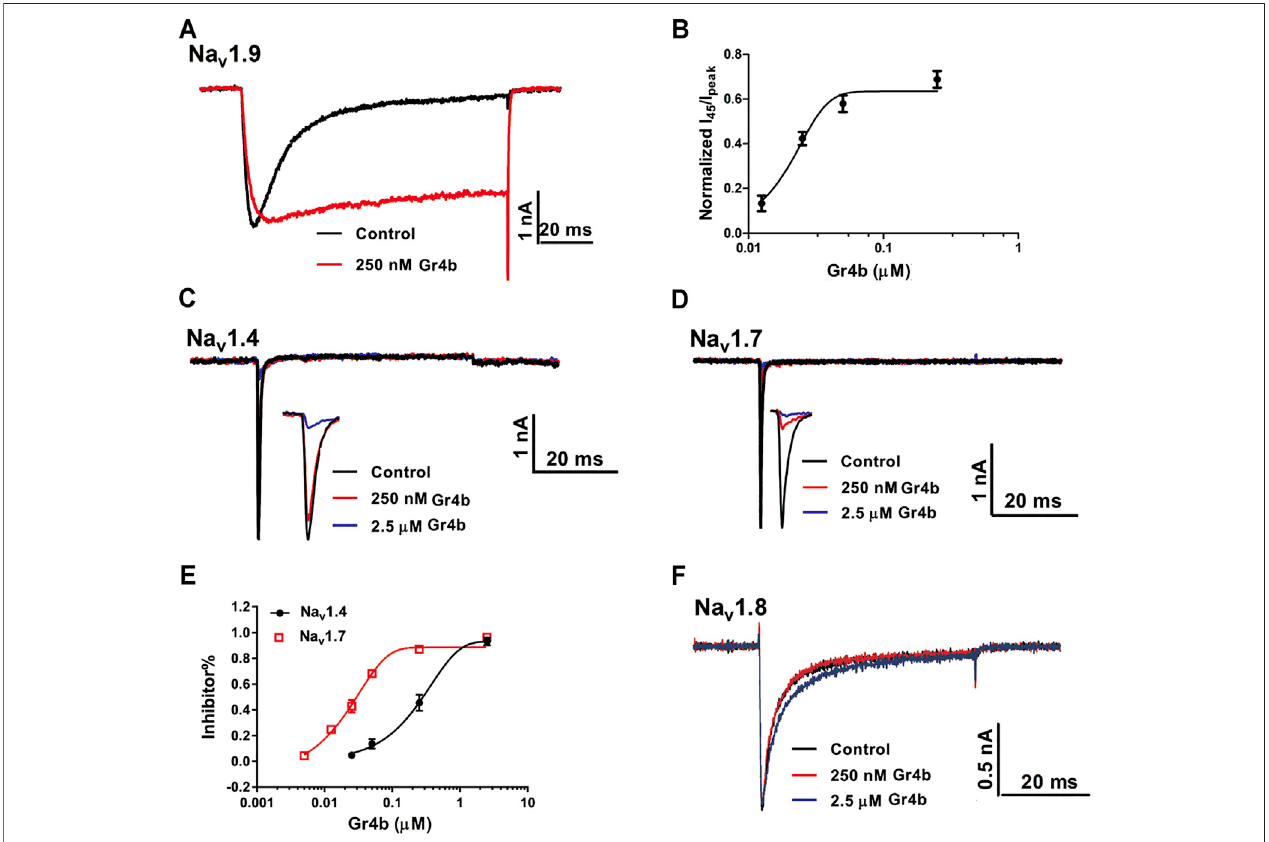
FIGURE2| EffectofGr4bonNa v channelsubtypes. (A) RepresentativecurrenttracesshowingthatGr4bslowedthefastinactivationofNa v 1.9expressedinND7/ 23cells.Thecurrentsevokedby100 msdepolarizationto − 40 mVfromholdingpotentialsof − 120 mV. (B) Thedose-responsecurvesfortheGr4b-inducedinhibitionof the fast inactivation ofNa v 1.9, EC 50 of25 ± 1 nM (n (cid:2) 6). (C,D) Representative current traces show thatGr4b blocked the currents ofNa v 1.4 and Na v 1.7. Currents were elicited by 50 ms depolarizing steps to − 10 mV from a holding potential of − 90 mV. (E) Dose-response curves for Gr4b inhibiting Na v 1.4 and Na v 1.7 currents. The IC 50 valueswere411 ± 184 nMand27 ± 3 nMforhNa v 1.4and Na v 1.7,respectively(n (cid:2) 4 – 6). (F) RepresentativetracesshowthattheNa v 1.8currentsareunaffectedby Gr4b (n (cid:2) 4). Representative current traces from ND7/23 cells expressing Na v 1.8 in the absence (black) and presence of 250 nM (red) or 2.5 μ M (blue) Gr4b. Currents were elicited by 50 ms depolarizing steps to 10 mV from a holding potential of − 90 mV.